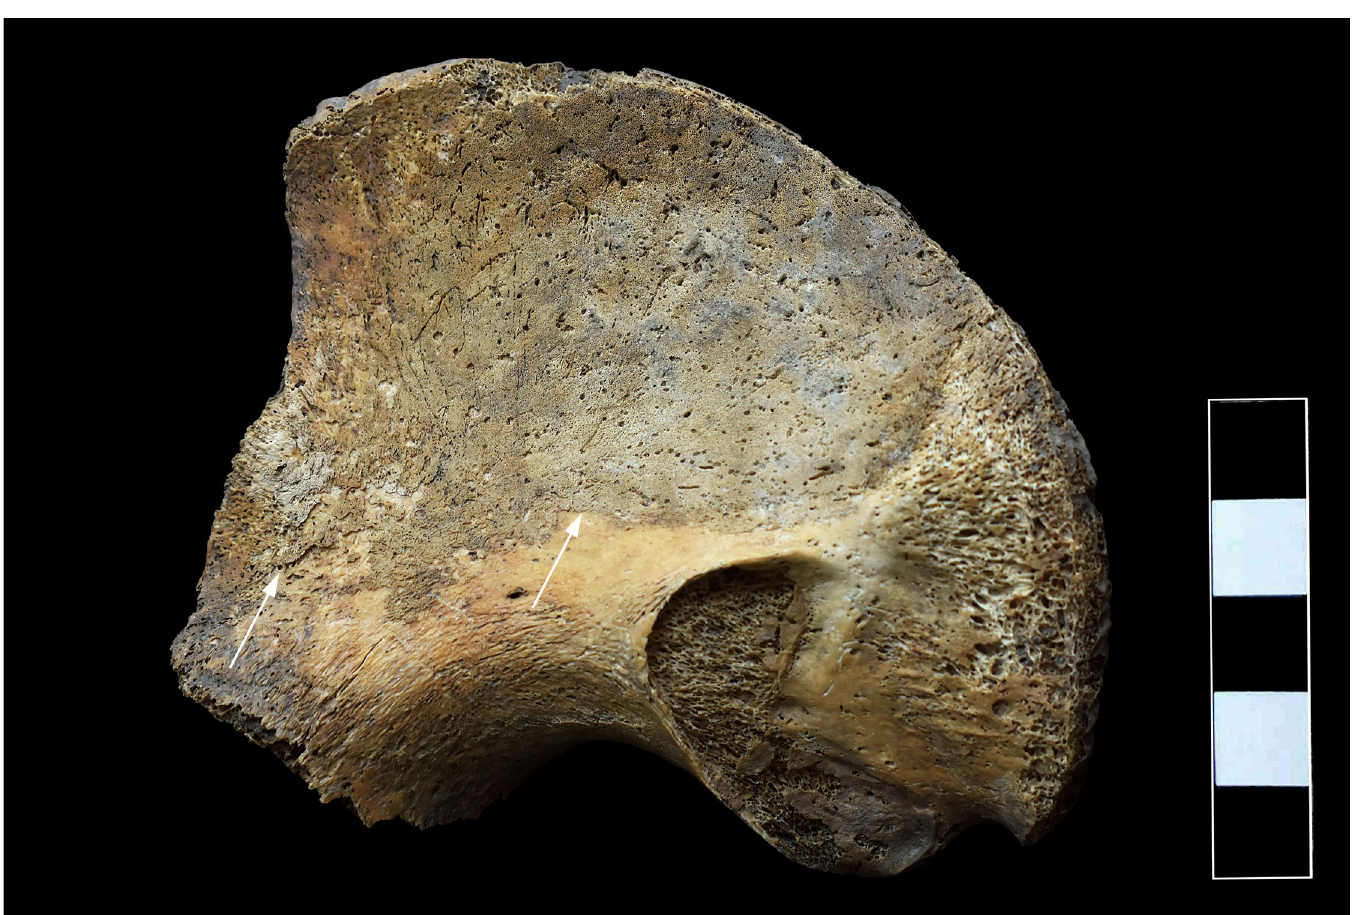
Fig 12. Reactive new bone formation on the iliac fossa of the right iliac wing (white arrows).